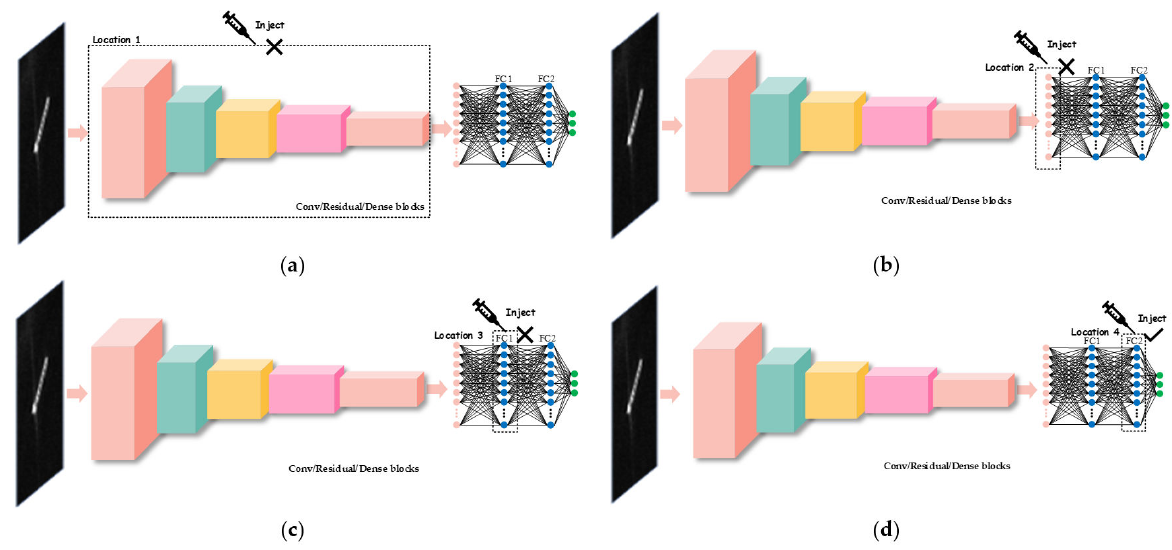
Figure 10. Where to inject. ( a ) Location 1: Conv/Residual/Dense blocks; ( b ) location 2: 1D reshaped CNN-based features; ( c ) location 3: the internal FC layer; ( d ) location 4: the final FC